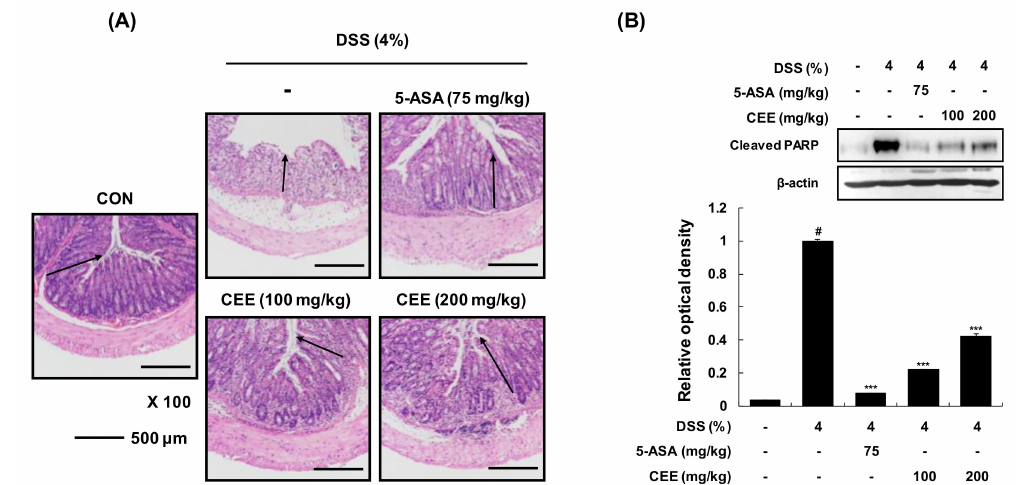
Figure 4. E ff ects of CEE on colon histology in DSS-fed colitis mice. After administration with or without CEE (100 or 200 mg / kg / day p.o.) for 9 days, ( A ) the histological changes were analyzed by H&E staining. Crypt damage was observed by Olympus cellSens Standard image software (black arrow). ( B ) Cleaved PARP levels were examined by western blot analysis using whole protein lysates from colonic tissue. β -Actin was used as an internal control. The ratio of relative optical density was calculated by a densitometric analysis program (Bio-Rad Quantity One ® Software), normalized to the internal control. Data are presented as mean ± SDs of three independent experiments. # p < 0.001 vs. the vehicle-treated control group; * p < 0.05, ** p < 0.01, *** p < 0.001 vs. the DSS-fed colitis